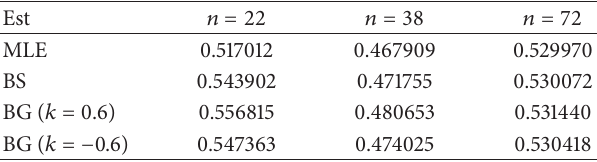
Table 2: Standard errors of the survival